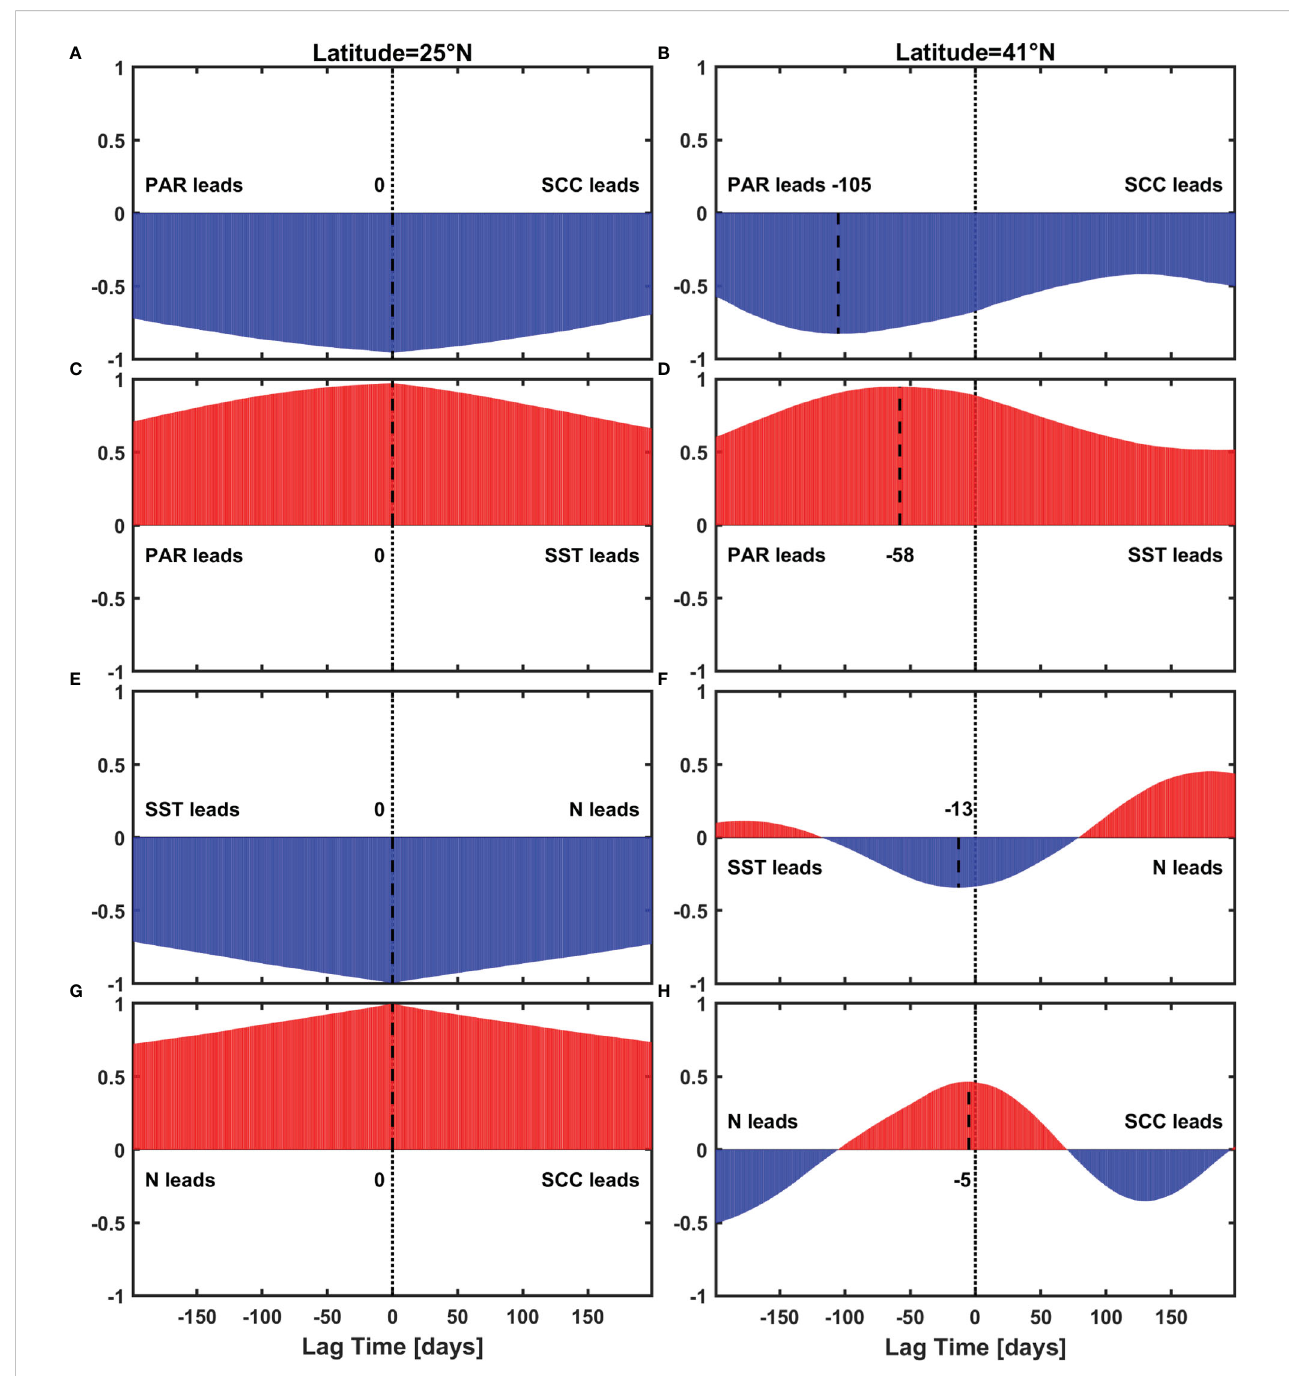
FIGURE 10 Lead-lag correlation result between (A) , (B) PAR and SCC (C) , (D) PAR and SST, (E) , (F) SST and N, (G) , (H) N and SCC, at 25°N (left module) and at 41°N (right module), black dash lines indicate the maximum